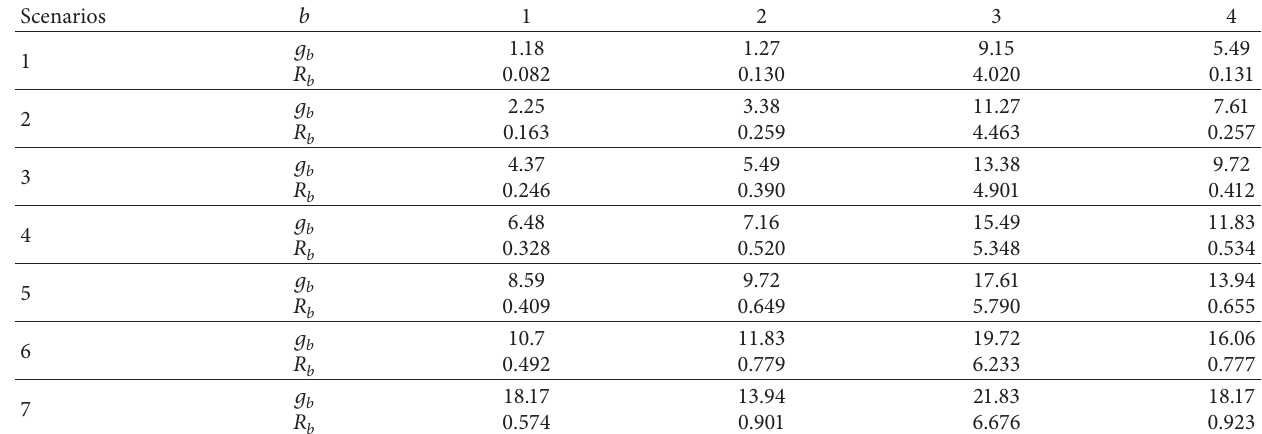
Figure 6: Cost comparison of refrigerated and nonrefrigerated vehicles. Table 7: Parameter setting for unit packaging cost and packaging thermal